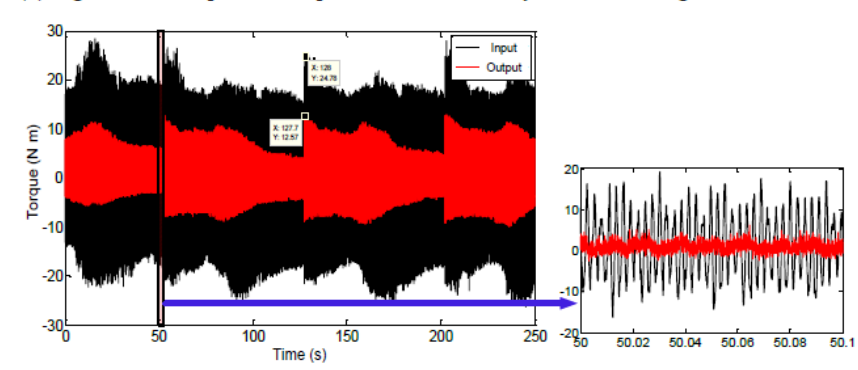
Figure 17. Comparison of vibration responses of different fan-shaped structures.